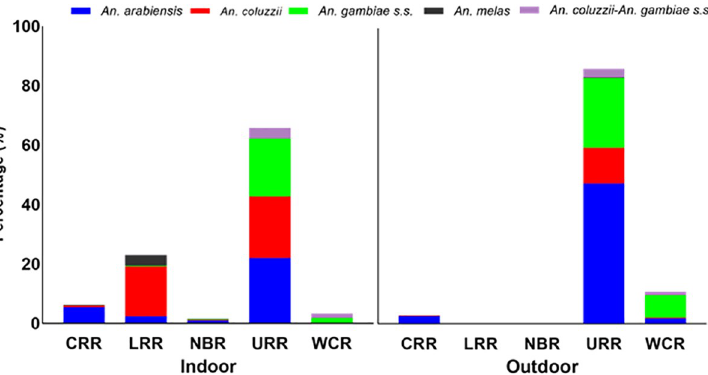
Fig 2. Distribution of Anopheles gambiae s . l by region as collected indoors and outdoors. An . col uzzii-An. gambiae s . s . are the hybrids of An . coluzzii and An . gambiae s . s . Mosquitoes were collected from 5 regions: CRR- central river region, LRR-lower river region. NBR- north bank region. URR-upper river region and WCR- West coast region. Overall, the number of mosquitoes resting indoors (421, 49.9%) and outdoors (423, 50.1%) were similar. Nevertheless, the resting preference varied by species. A significantly higher pro- portion of An . arabiensis were found outdoor (26.1%) than indoor (15.4%) (Pearson X 2 = 22.7, df = 4, P < 0.001) while both An . coluzzii (19.1% indoor and 6.3% outdoor, Pearson X 2 = 55.0, df = 4, P < 0.001) and An . melas (1.9% indoor and 0.1% outdoor, Pearson X 2 = 13.3, df = 4, P < 0.01) preferred resting indoor. For An . gambiae s . s . (10.9% indoor and 15.6% outdoor, Pearson X 2 = 7.0, df = 4, P = 0.14) and An . coluzzii-An . gambiae s . s . hybrids (2.6% indoor and 2% outdoor, Pearson X 2 = 0.7, df = 4, P = 0.45), there was no significant difference between resting indoor and outdoor. In URR, the region with the highest malaria transmission in the Gambia, An . arabiensis was most abundant vector (45.8%, 294) (indoor: 14.5%, outdoor: 31.3%), followed by An . gambiae s . s . (28.4%, 182) (indoor: 12.8%, outdoor: 15.6%) and An . coluzzii (21.5%, 138) (indoor: 13.6%, outdoor: 7.9%). No An . gambiae s . s . was collected in CRR while An . melas was mainly found in LRR (N = 15). All mosquitoes collected from LRR and NBR were resting indoors. The hybrids of An . coluzzii and An . gambiae s . s . were mainly found